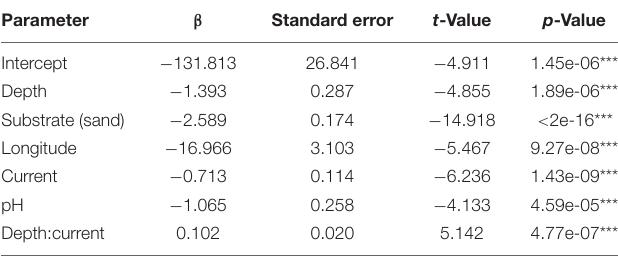
TABLE 2 | Fixed-effect GLM model results with a Tweedie distribution ( R 2 = 62%), explaining density distribution patterns of Holothuria mammata at Arrábida, Setúbal.